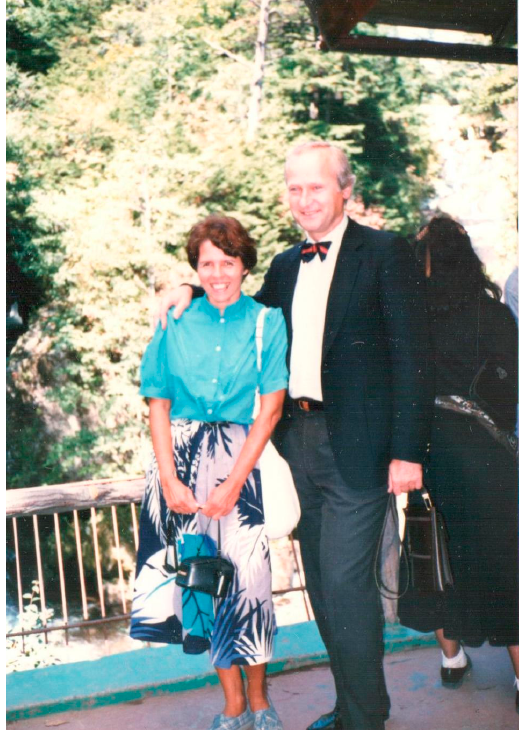
Figure 2. Who knew her work—respected her. Who knew her as well—also liked her. Conflicts of Interest: The authors declare no conflict of interest.